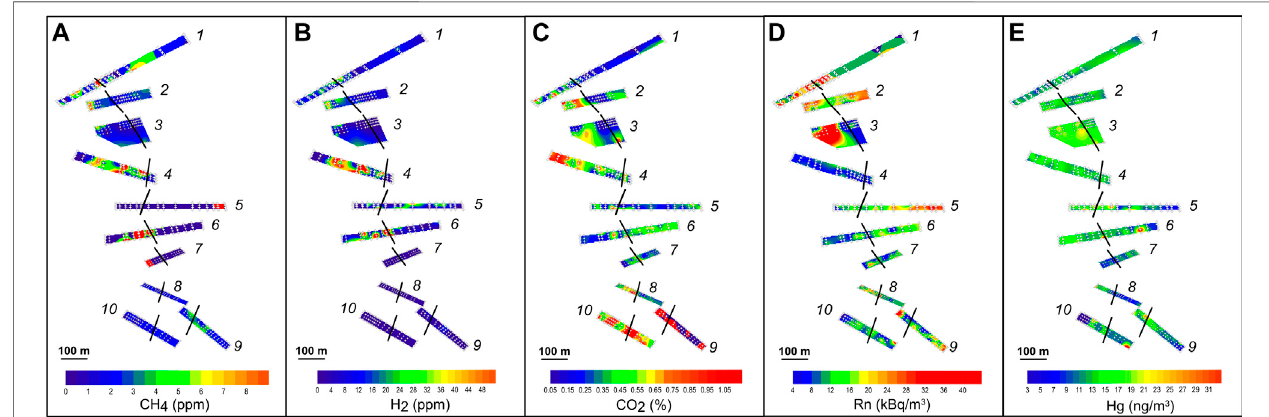
FIGURE 5 | Spatial distribution of soil-gas concentrations from M1 – M10 in the XXFS. The white cross shows the distribution of the measurement points.